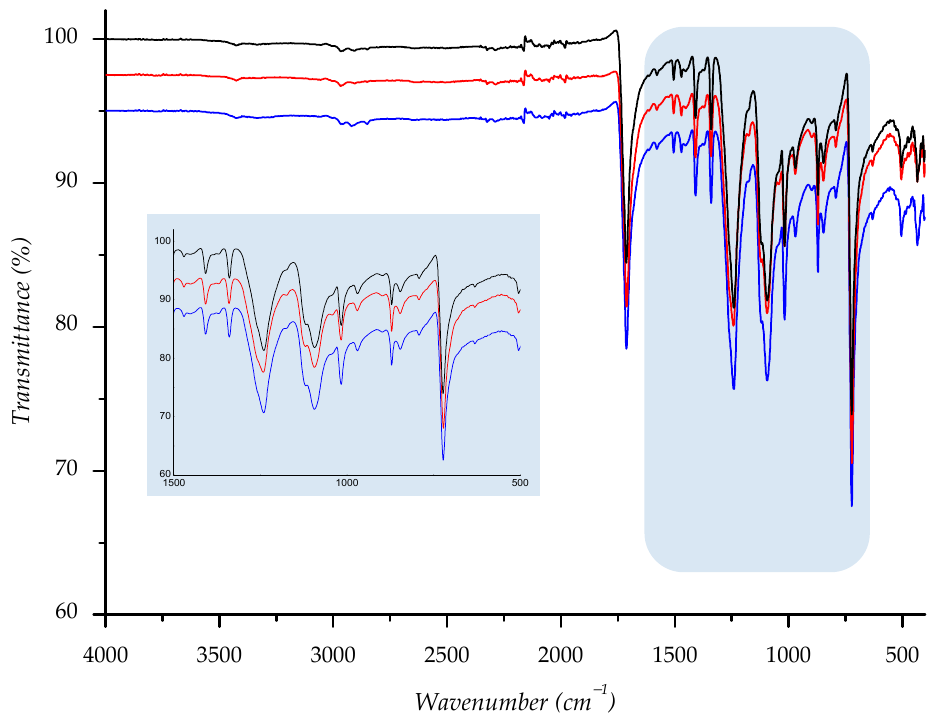
Figure 14. IR spectra of investigated sample F1 ((—) = starting material; (—) = material aged in sun; (—) = material aged in shade) with enlarged fingerprint region (colored in blue).